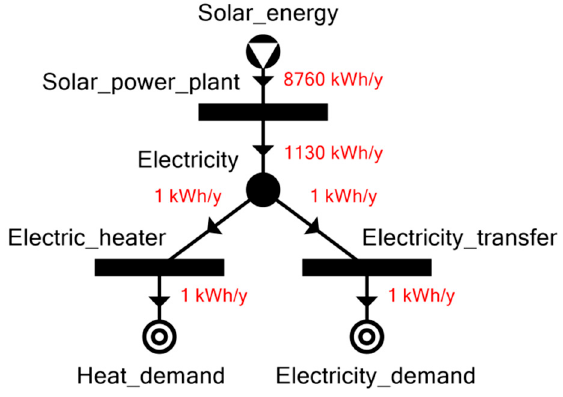
Figure 5. Model for the solar energy utilization.